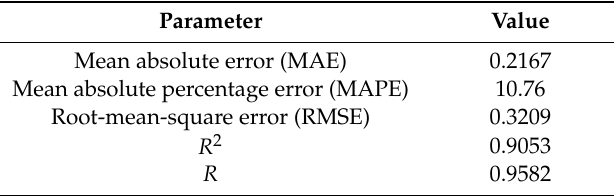
Table 1. Result values from the